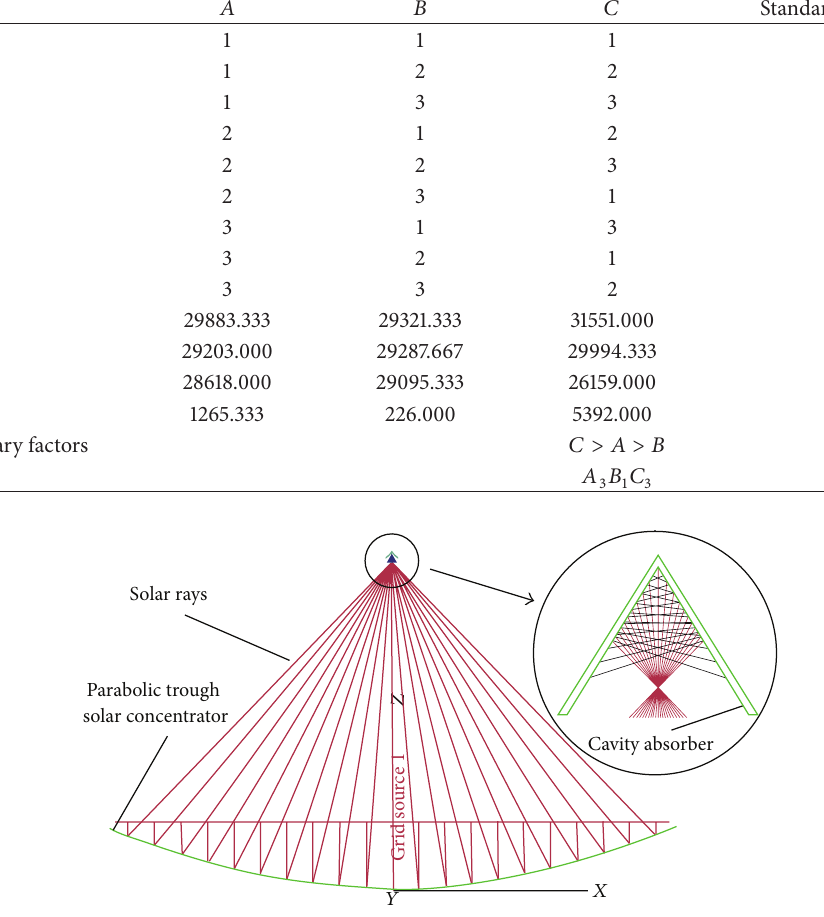
Figure 10: The optical properties of optimized designed cavity